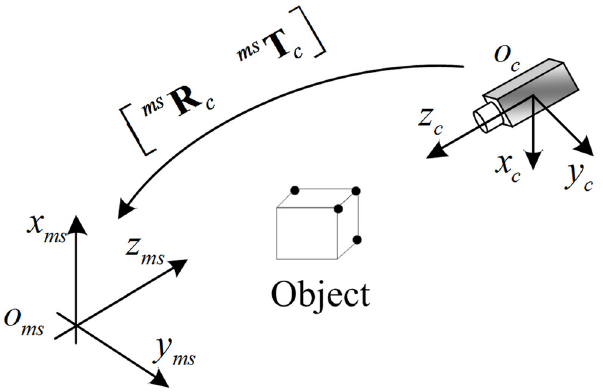
Fig 3. Coordinate systems of object moving. O ms -X ms Y ms Z ms represents the measurement reference.